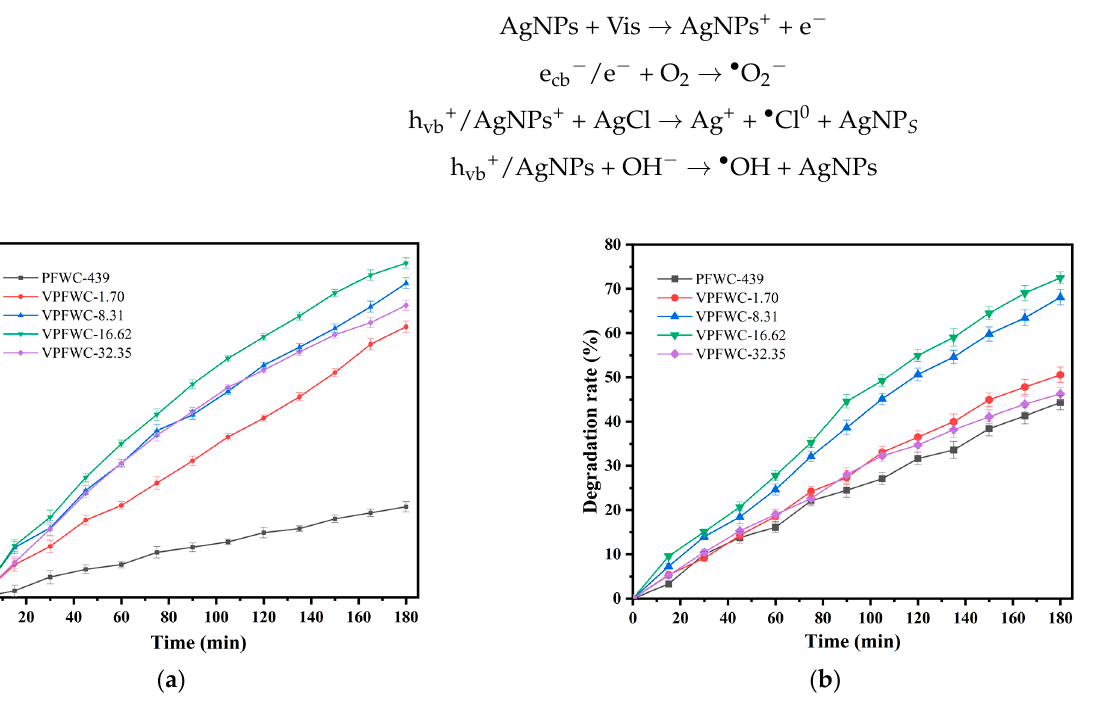
Figure 7. The photocatalytic degradation rates of gaseous toluene on the PFWC-439 and the VPFWC-n, with different Ag surface deposits under visible/ultraviolet light: ( a ) visible photocatalytic degradation of the PFWC-439 and the VPFWC-n by visible light; ( b ) photocatalytic degradation of the PFWC-439 and the VPFWC-n by ultraviolet light.